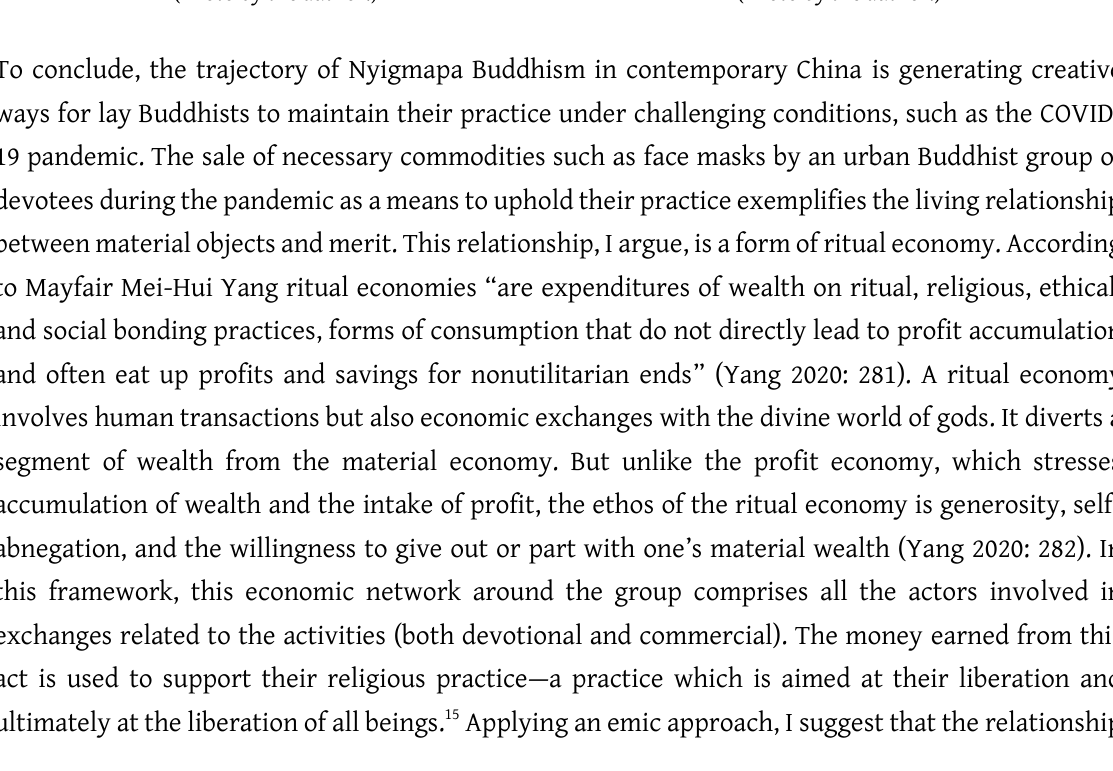
Figure 2: Group practice, October 2018. (Photo by the author.)